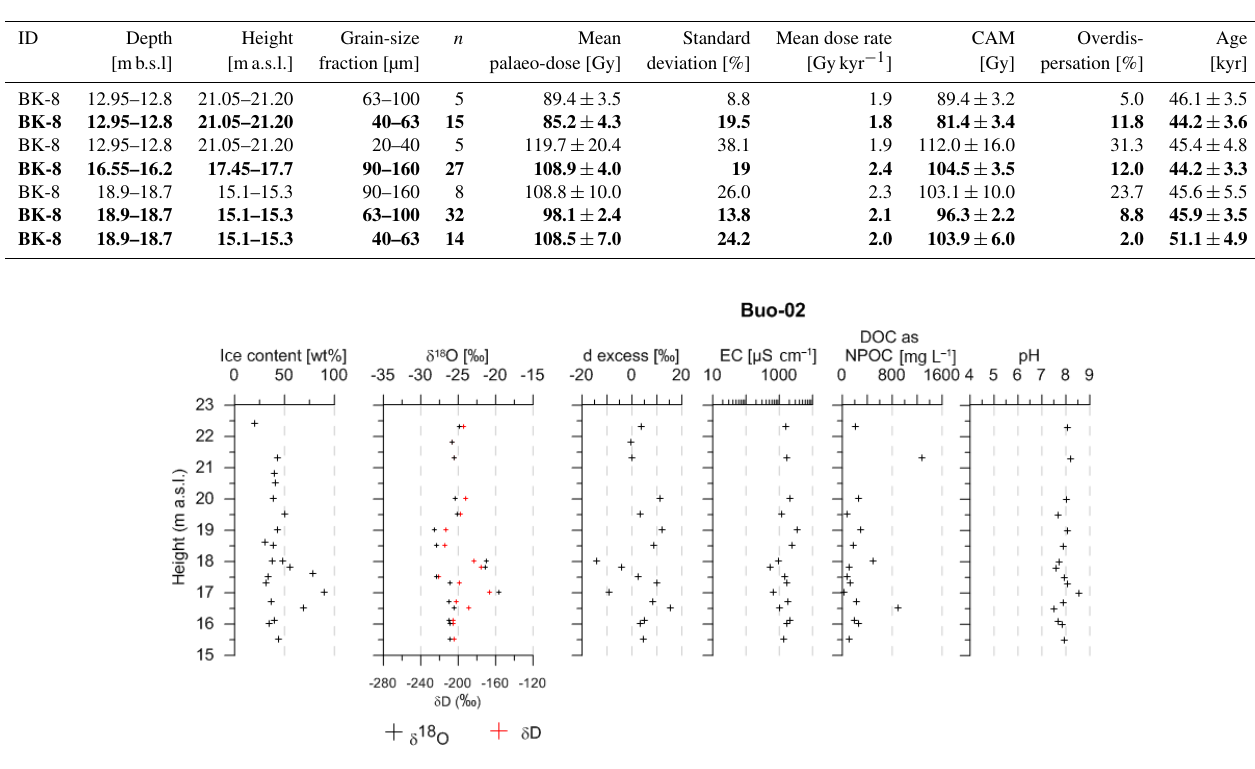
Figure 9. Measurements of ice content, isotope ratios, electrical conductivity (EC), pH, and solutes over height in ma.s.l. for samples from the Buo-02